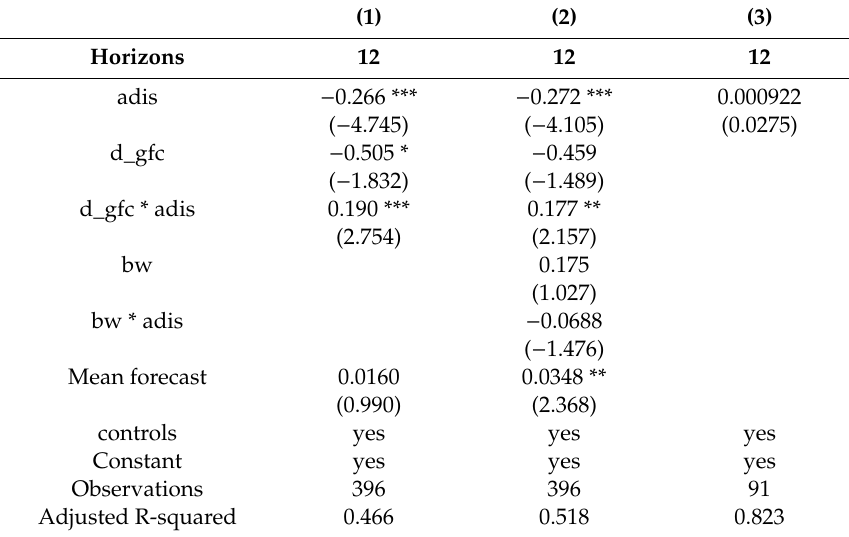
Table 7. The Global Financial Crisis and dispersion e ff